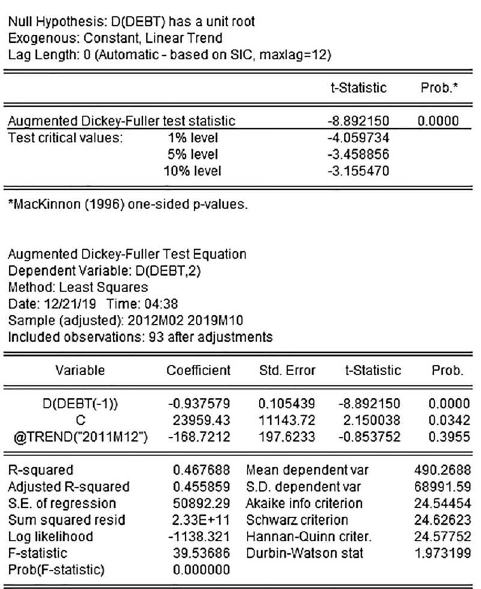
Figure 2. The results of the Dickey-Fuller test to verify the time series in the stationarity equations